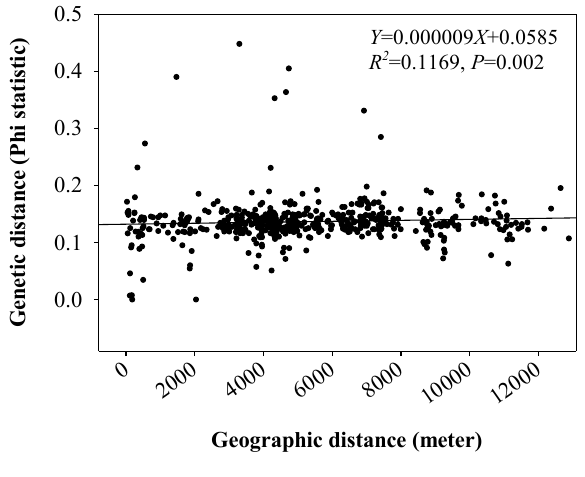
Figure 6. Correlation analysis between genetic and geographic distances for the 32 defined patches within the remnant population of hairy